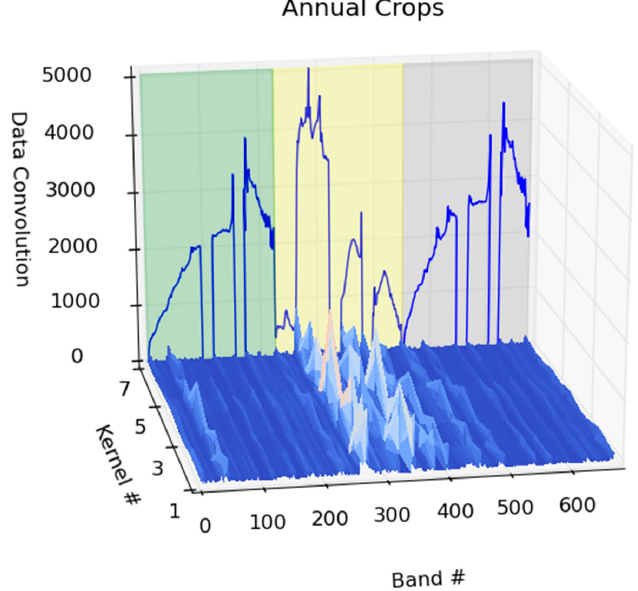
Figure 7. An example convolutional feature map for an Annual Crop three-season spectrum. The example class spectrum is shown in background. Green, yellow and gray background areas represent bands in the spring, summer and fall, respectively. Each season has 186 bands, ordered 370 to 2500 nm. However, in this figure the original 224 bands per season are shown in order to display the bad data gaps (e.g., atmospheric absorption windows).